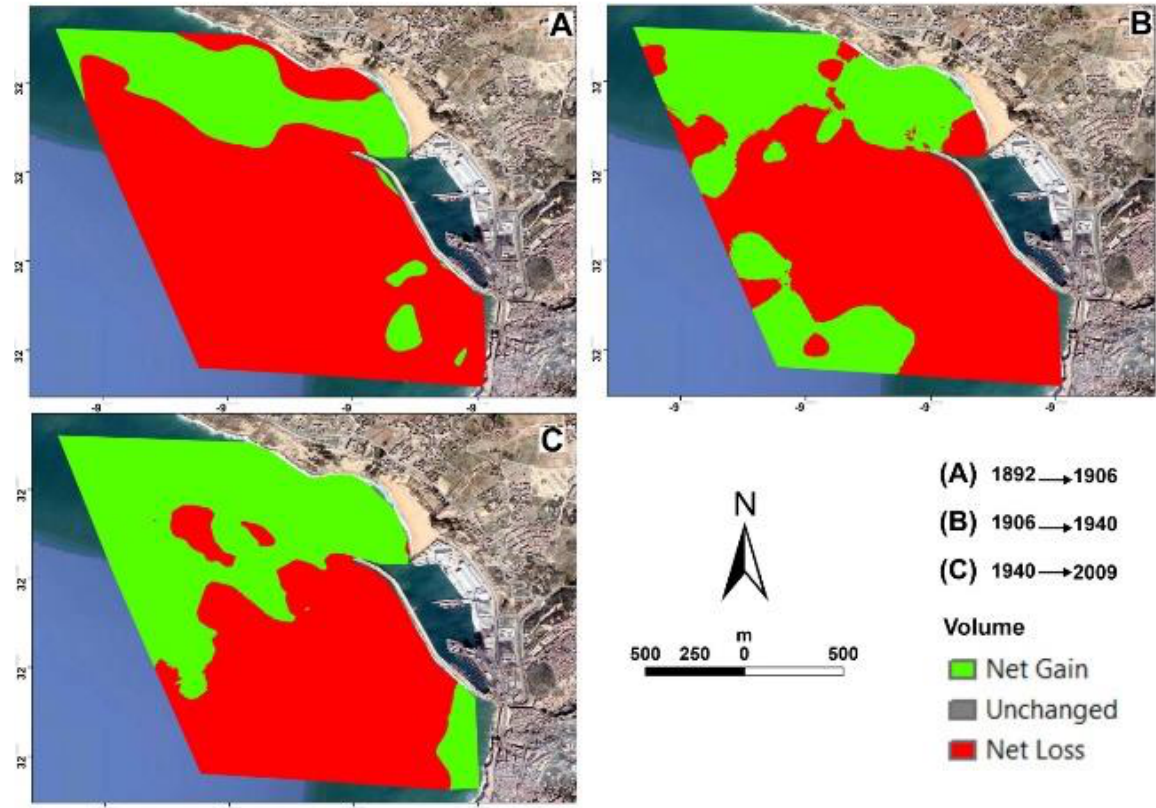
Figure 5. Bathymetric difference maps of Safi Bay during the period